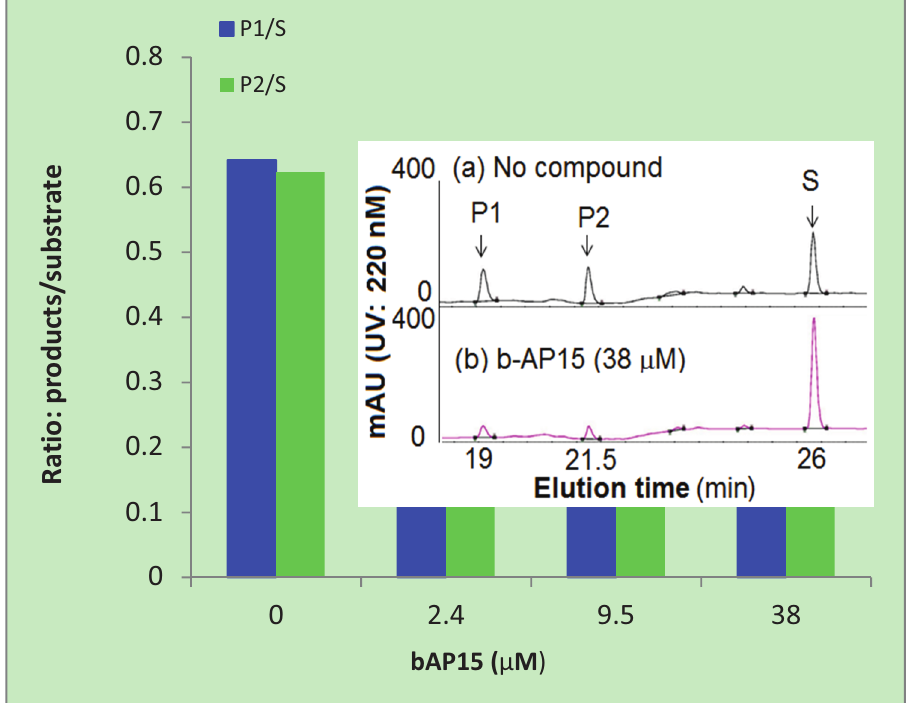
Figure 3. Inhibition of the chymotrypsin-like activity of the 20S proteasome. The reaction products of the 20S proteasome, AMC (P1), Suc-LLVY (P2), and substrate Suc-LLVY-AMC (S) were analyzed by HPLC. P1/S and P2/S are the ratios of the reaction products and the substrate calculated from the area under the curve of the HPLC